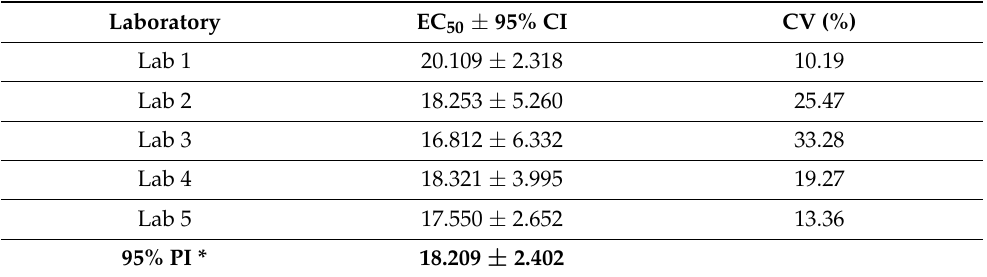
Table 6. Summary of interlaboratory test results from the Lemna toxicity test.